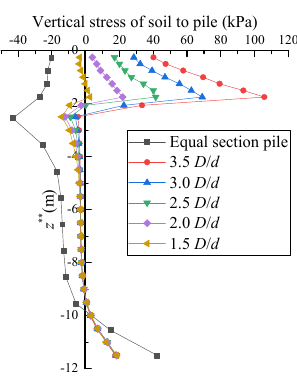
Figure 11. The axial force on the pile.